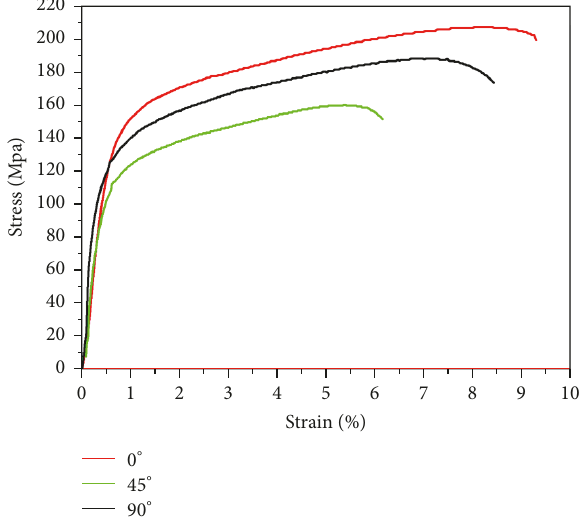
Figure 8: Engineering stress-strain curves of twin-roll cast Al-10Mg alloy plate at room